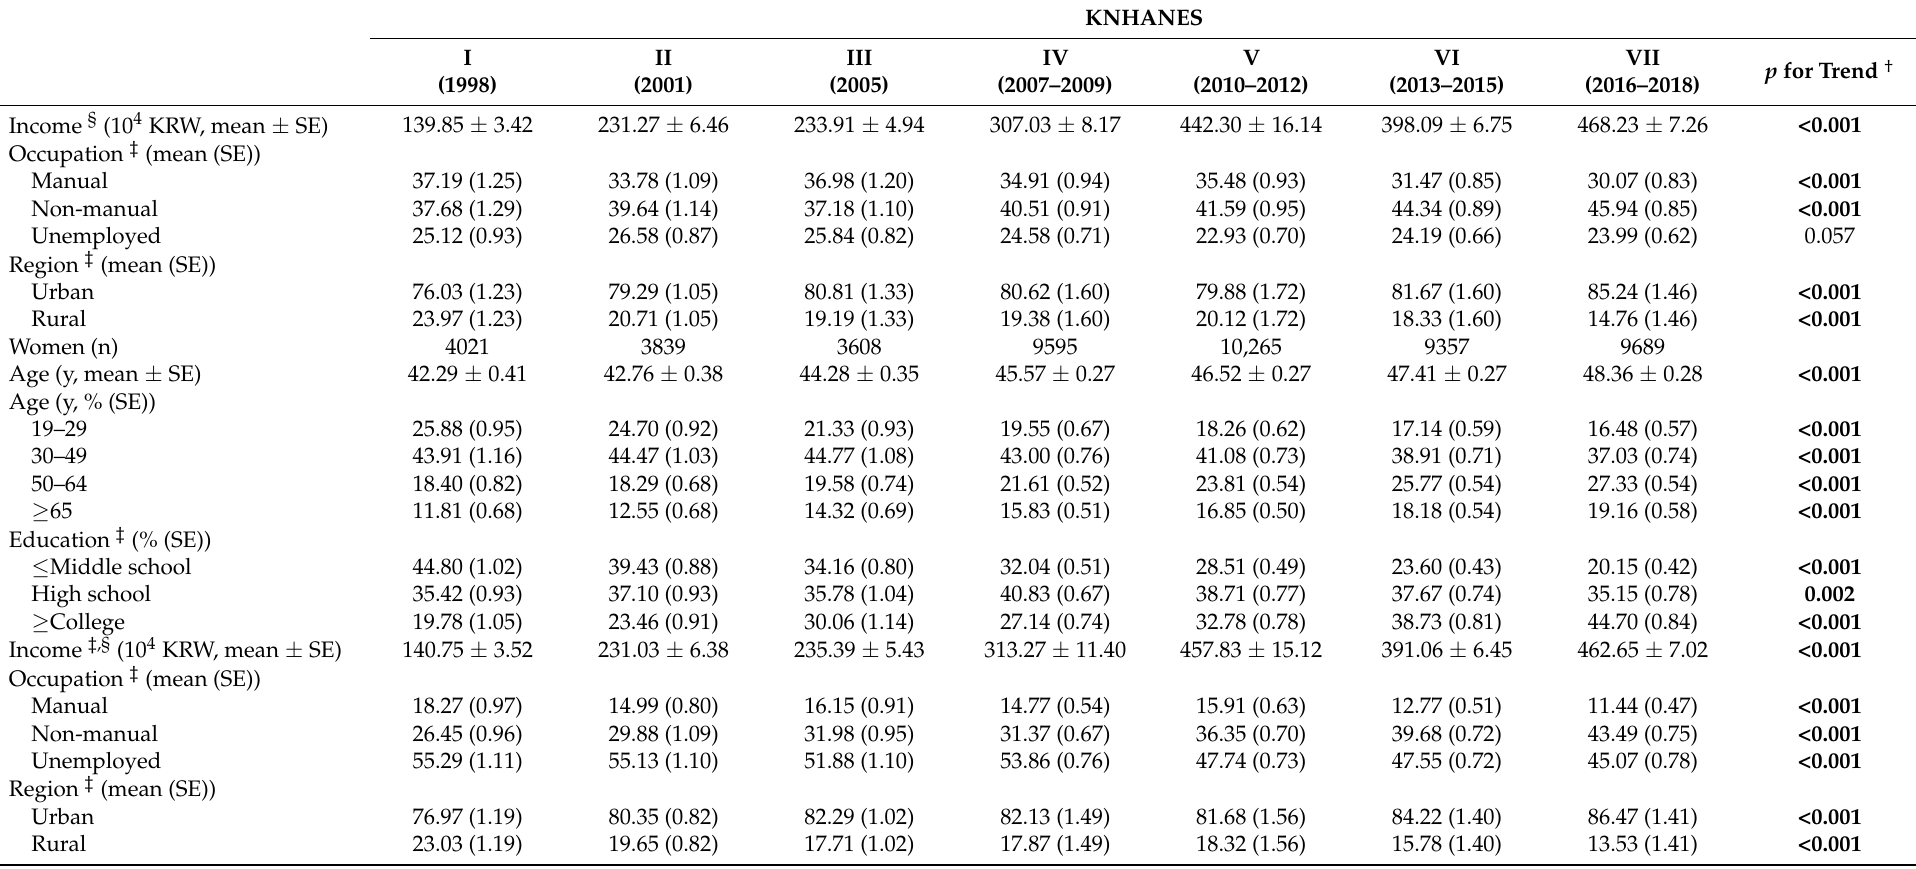
Bold values indicate p for trends < 0.05. † p for trends by multivariate linear regression for continuous variables (age and income) or logistic regression for categorical variables (each category of age, education, occupation, and region). ‡ Age-standardized based on the 2005 Korea census, and p for trends adjusting for age. § Household monthly income in Korean won (approximately 1082 Korean won equal to 1 U.S. dollar in